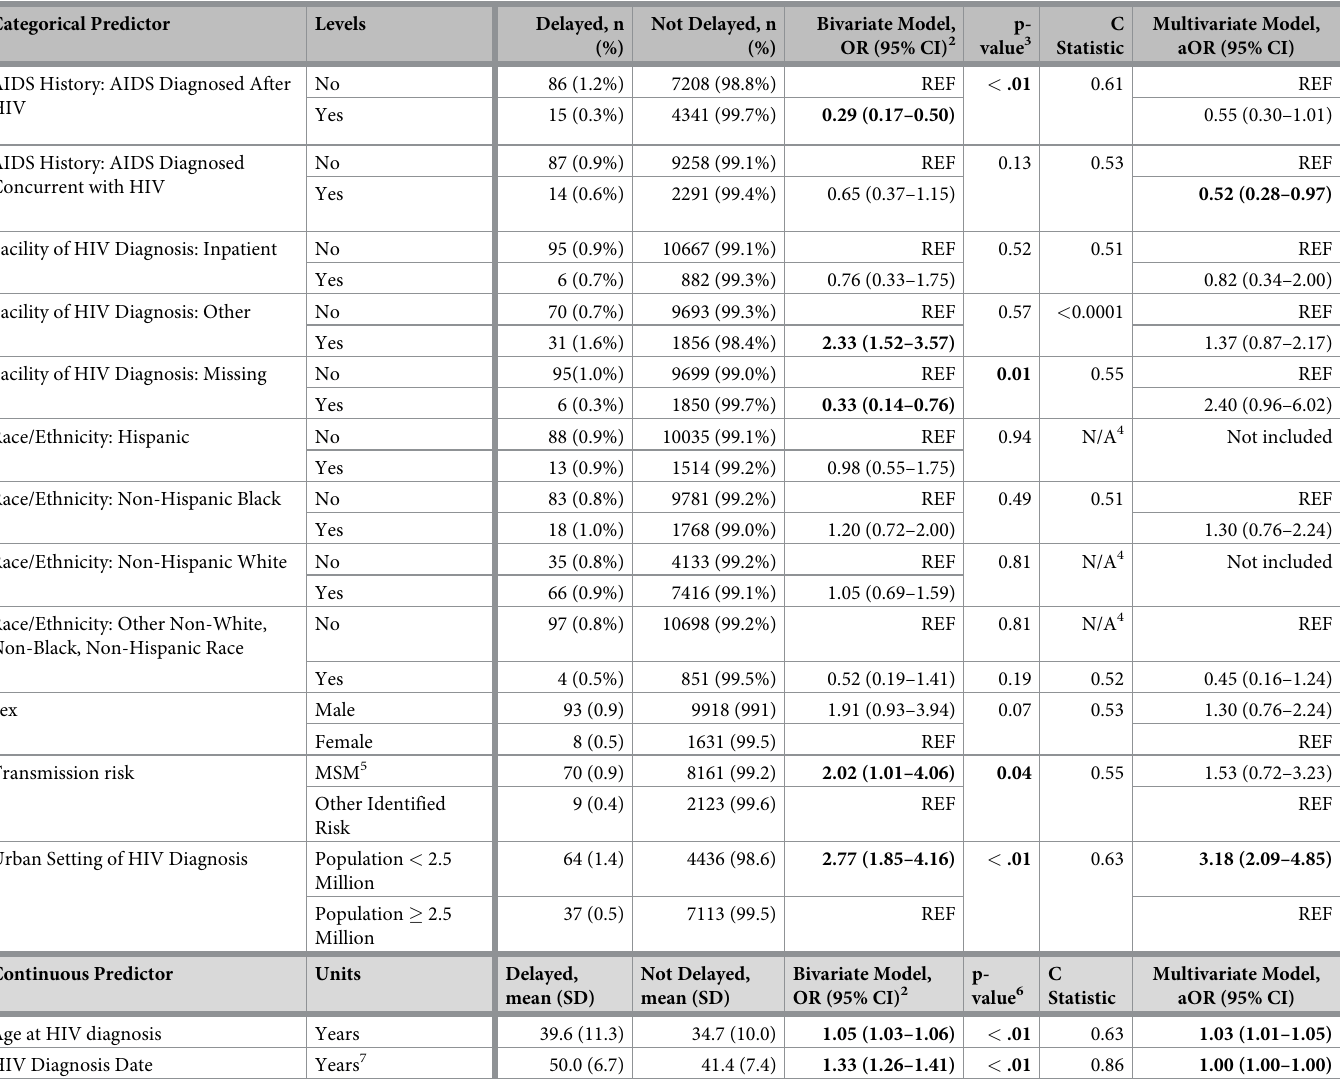
Table 2. Bivariate and multivariate associations between potential predictors and HIV case reporting delay using pooled data from Washington State, Case-Surveil- lance-Based Sampling demonstration project